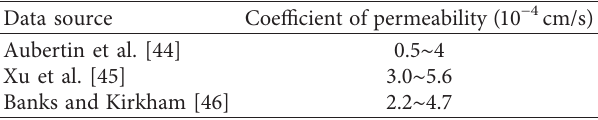
Table 5: Measured data of coefficient of permeability of tailings.